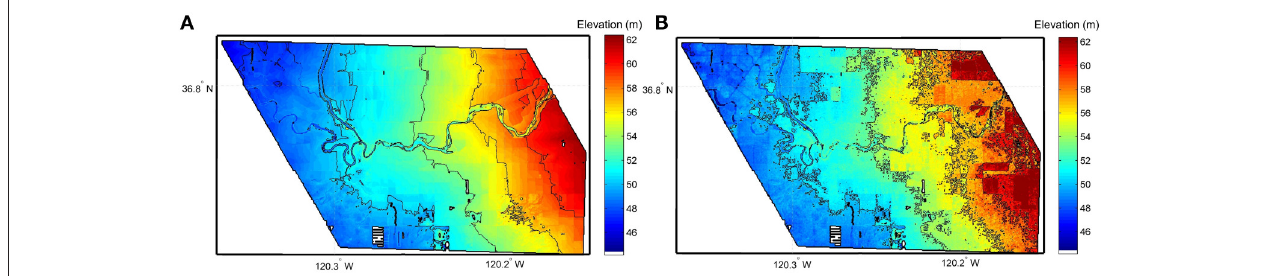
FIGURE 3 | (A) 30 30m aggregated LiDAR bare ground DEM with height contours overlain. (B) The same height interval contours are overlain on the InSAR DEM × aggregated to 30 30m after vegetation correction. ×